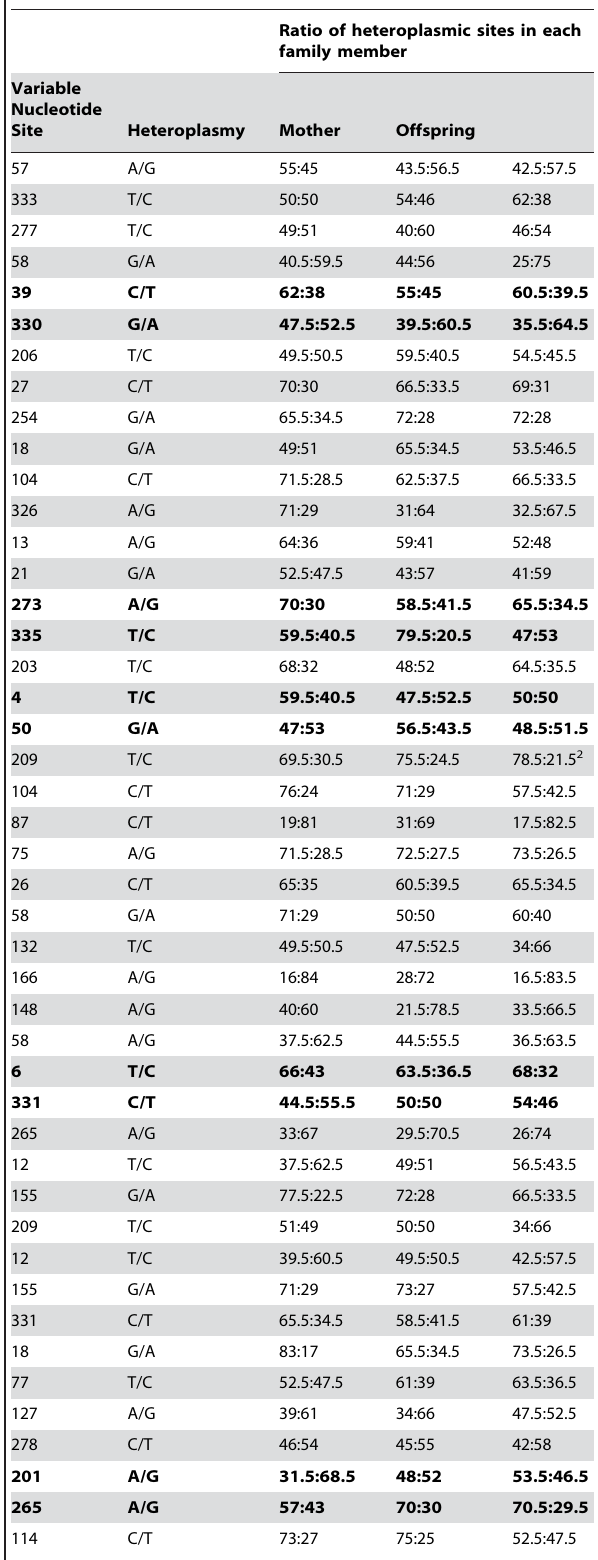
Ratio of heteroplasmic sites in each family